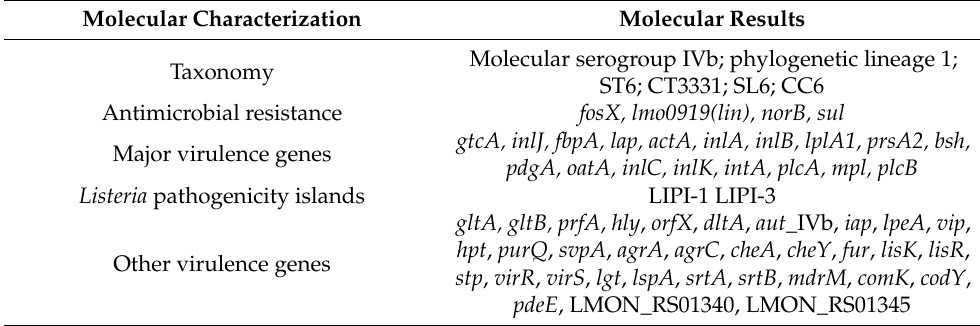
Table 1. WGS-based characterization of the L. monocytogenes strain under study. Molecular Characterization Molecular